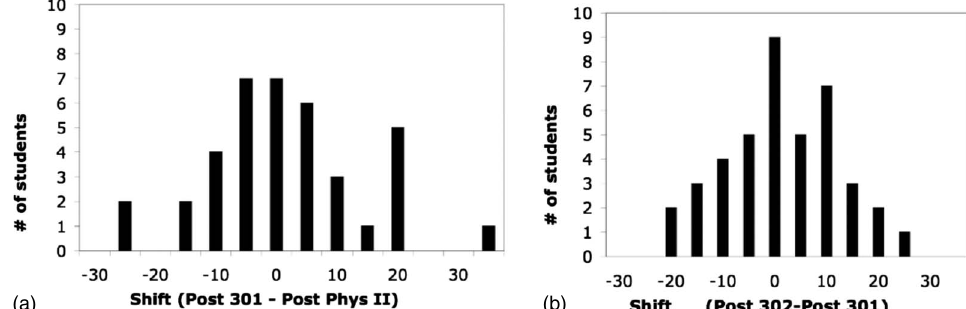
FIG. 2. Shift in post-BEMA scores. Fig a (cid:1) left (cid:2) shows a histogram of the shift in individual’s scores between freshman and junior courses, (cid:1) Student score as % after Phys 301 (cid:2) — (cid:1) Same students’ score after Phys II (cid:2) . The average of this distribution of shifts in score is 0 (cid:5) 2 % , statistically indistinguishable from zero. Fig b (cid:1) right (cid:2) shows a histogram of the shift in individual’s scores across upper-division courses, (cid:1) student scores after Phys 302 (cid:2) — (cid:1) same students’ score after Phys 301 (cid:2) . The average shift is −0.3 (cid:5) 2 points (cid:1) (cid:2) =11 % (cid:2) , statistically indis- tinguishable